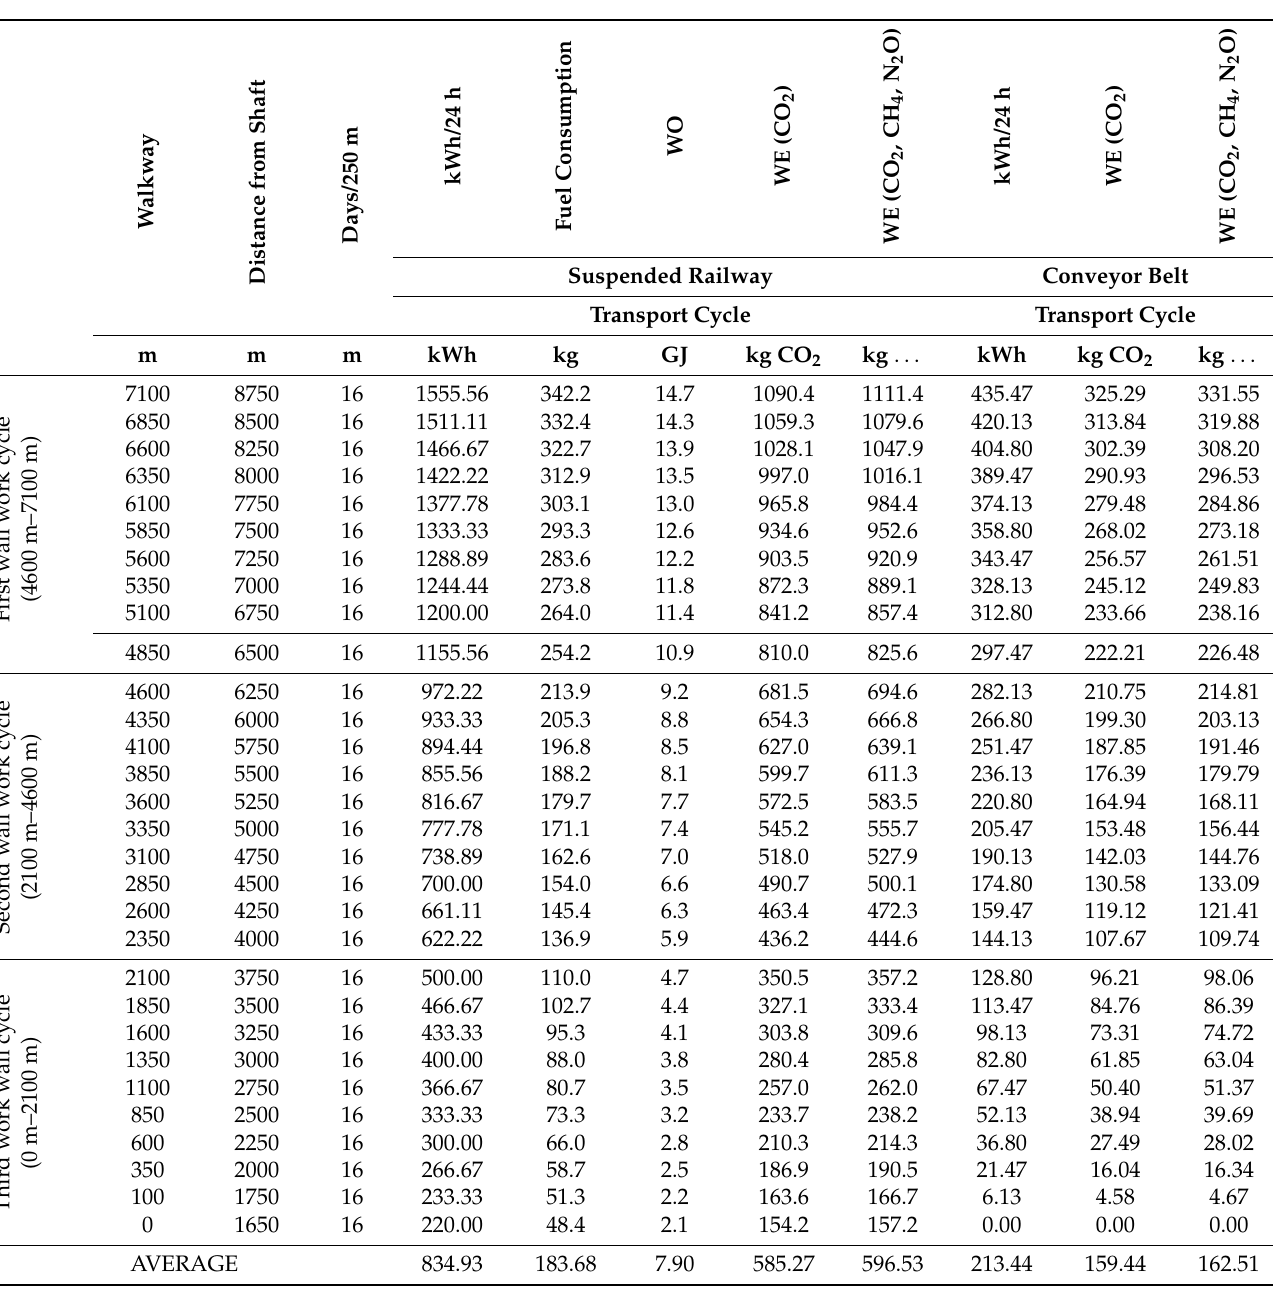
Table 6. Results of GHG energy intensity and emissivity calculations for the daily production